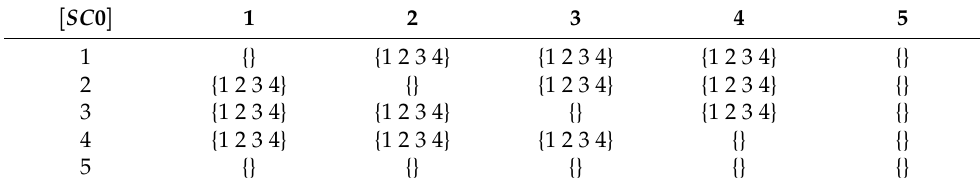
Table 6. Cycles no bigger than the double of the diameter for Figure 1.